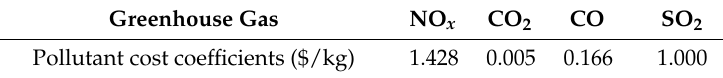
Table 2. Cost coefficient of pollutant emission.